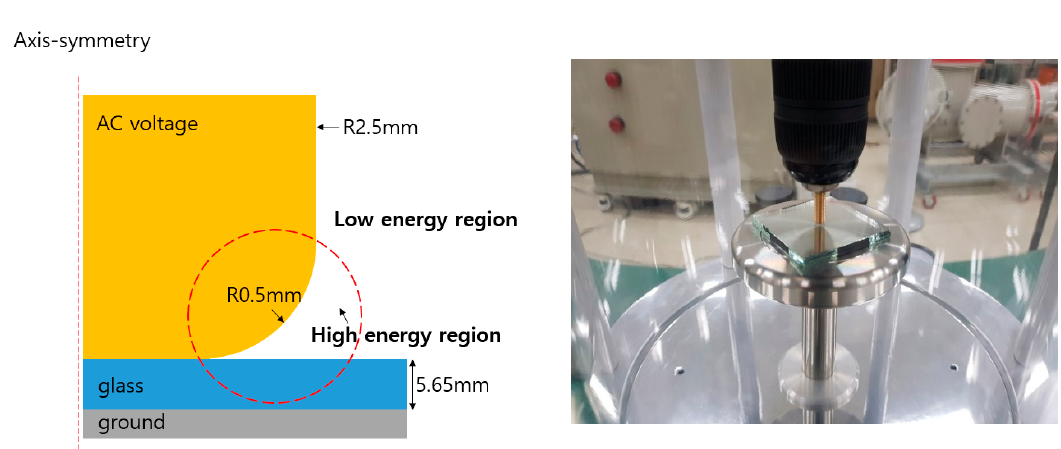
Figure 3. The two regions of decomposed gas generation by partial discharge and test cell.